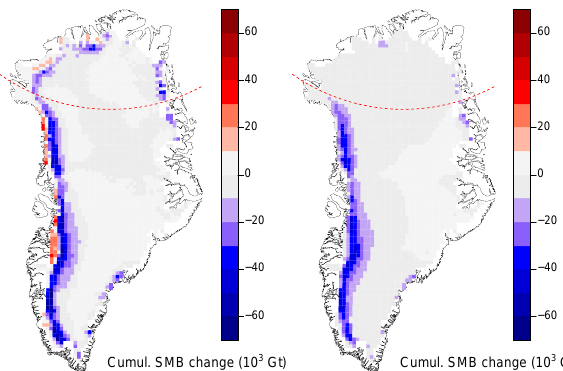
Fig. 8. Cumulative SMB change at the end of the NonUn 2080–2099 simulation: (left) target MAR simulation (perturbed minus control) and (right) result from maximum likelihood gradient set ˜ b applied to the NonUn height change (adjusted minus control). Red dashed line is 77 ◦